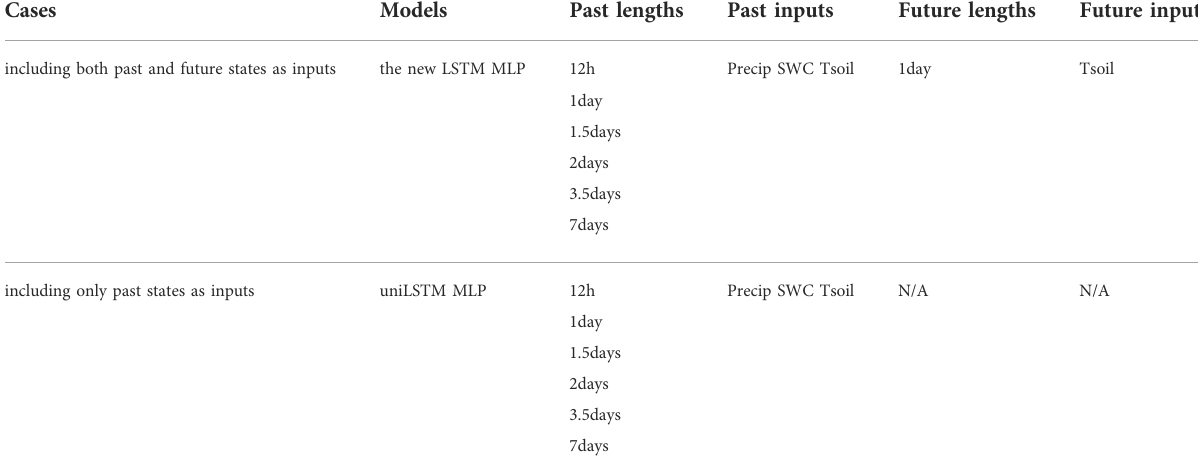
TABLE 1 Cases involving different temporal periods as inputs for estimating Rsoil and Precip/SWC/Tsoil using MLP, uniLSTM, and the new LSTM.